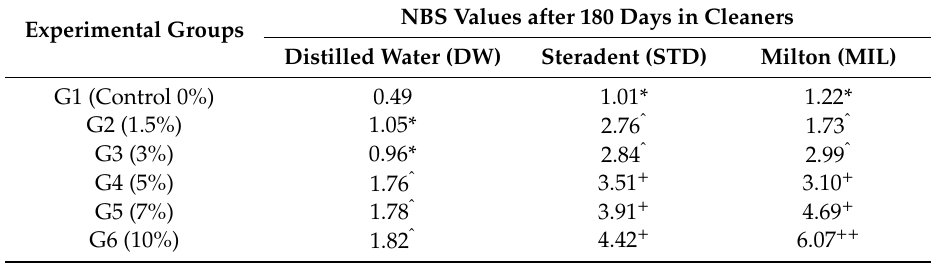
Table 6. Colour change values according to NBS unit system after storing the samples for 180 days in different denture cleaners. Experimental Groups